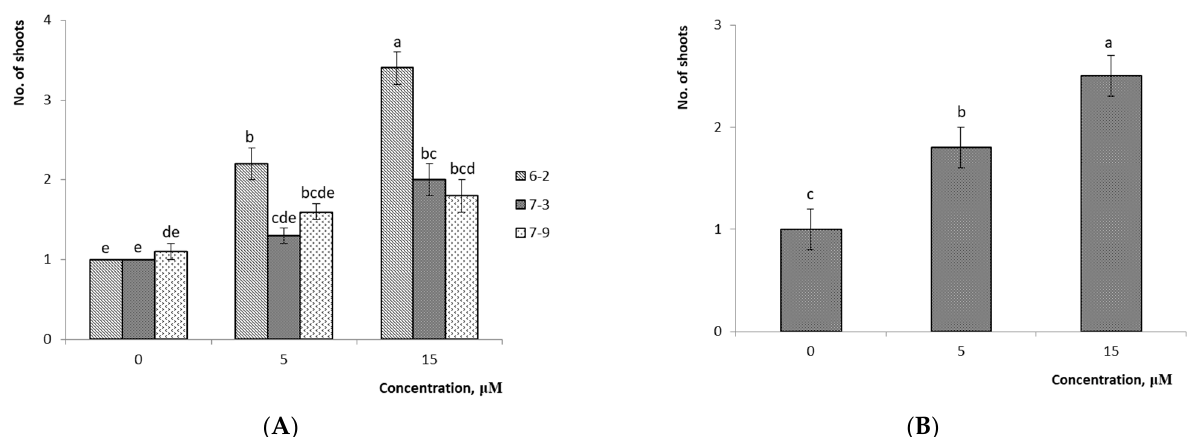
Figure 4. Effect of 2iP concentration on the multiplication rate of V.ul. 8 × ‘NC’: ( A ) detailed analysis of values of hybrid variants; ( B ) average values of hybrid variants. Means followed by the same letter are not significantly different according to the LSD at p ≤ 0.05. Note: *—conglomerate of shoots variant No. 4-6; 1-1, 1-2, 1-5, 2-2, 4-2, 4-6, 4-8, 5-3—variant Nos. 1-1,